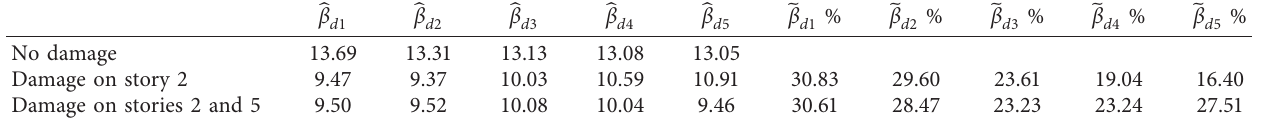
Table 3: Variation of the estimated parameters β